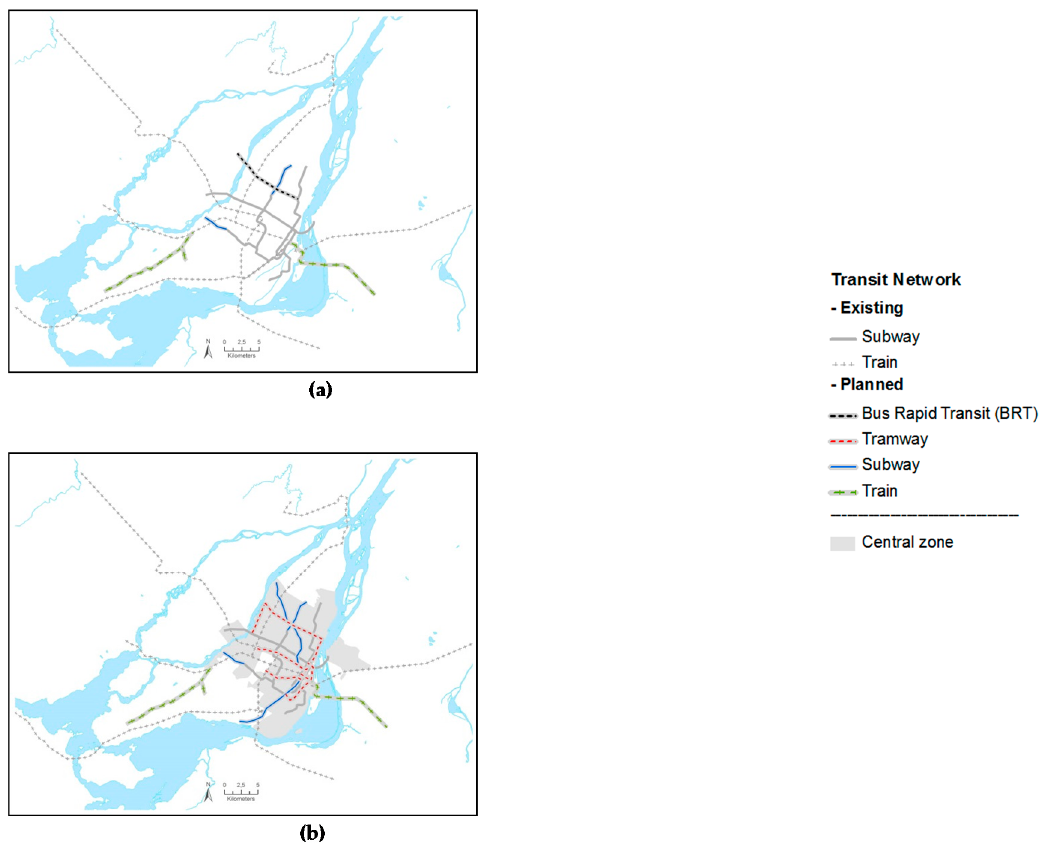
Figure 2. Future public transit infrastructures associated with 2031 alternative scenarios; ( a ) Planned and transit-oriented development (TOD)100% scenarios; ( b ) Central scenario.